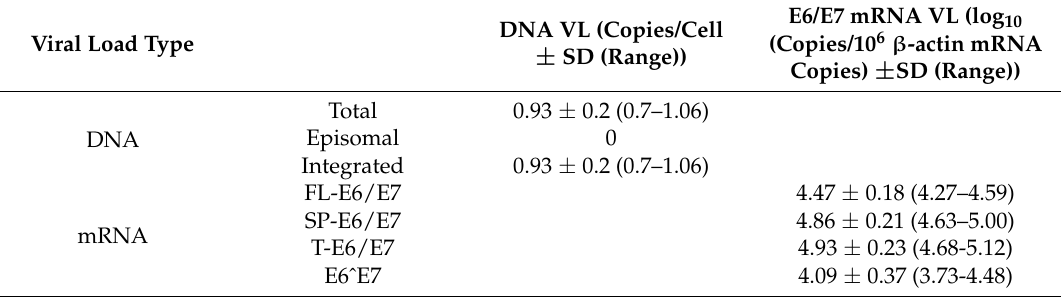
Table 3. Quantification of HPV16 DNA and E6/E7 mRNA VLs in SiHa cells.